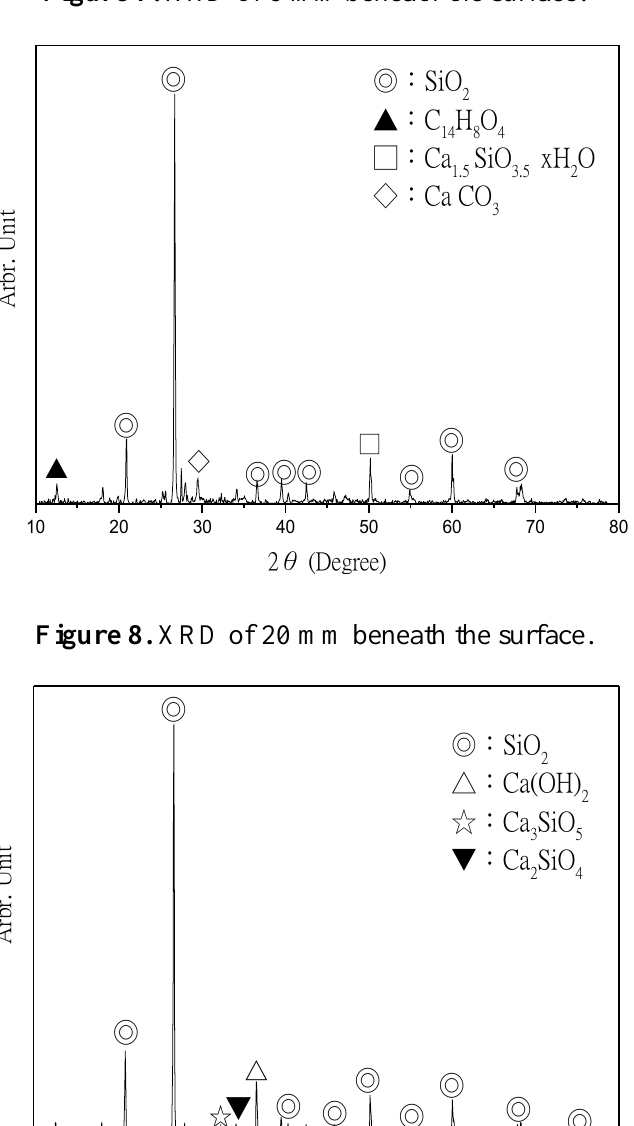
Figure 7. XRD of 5 mm beneath the surface.